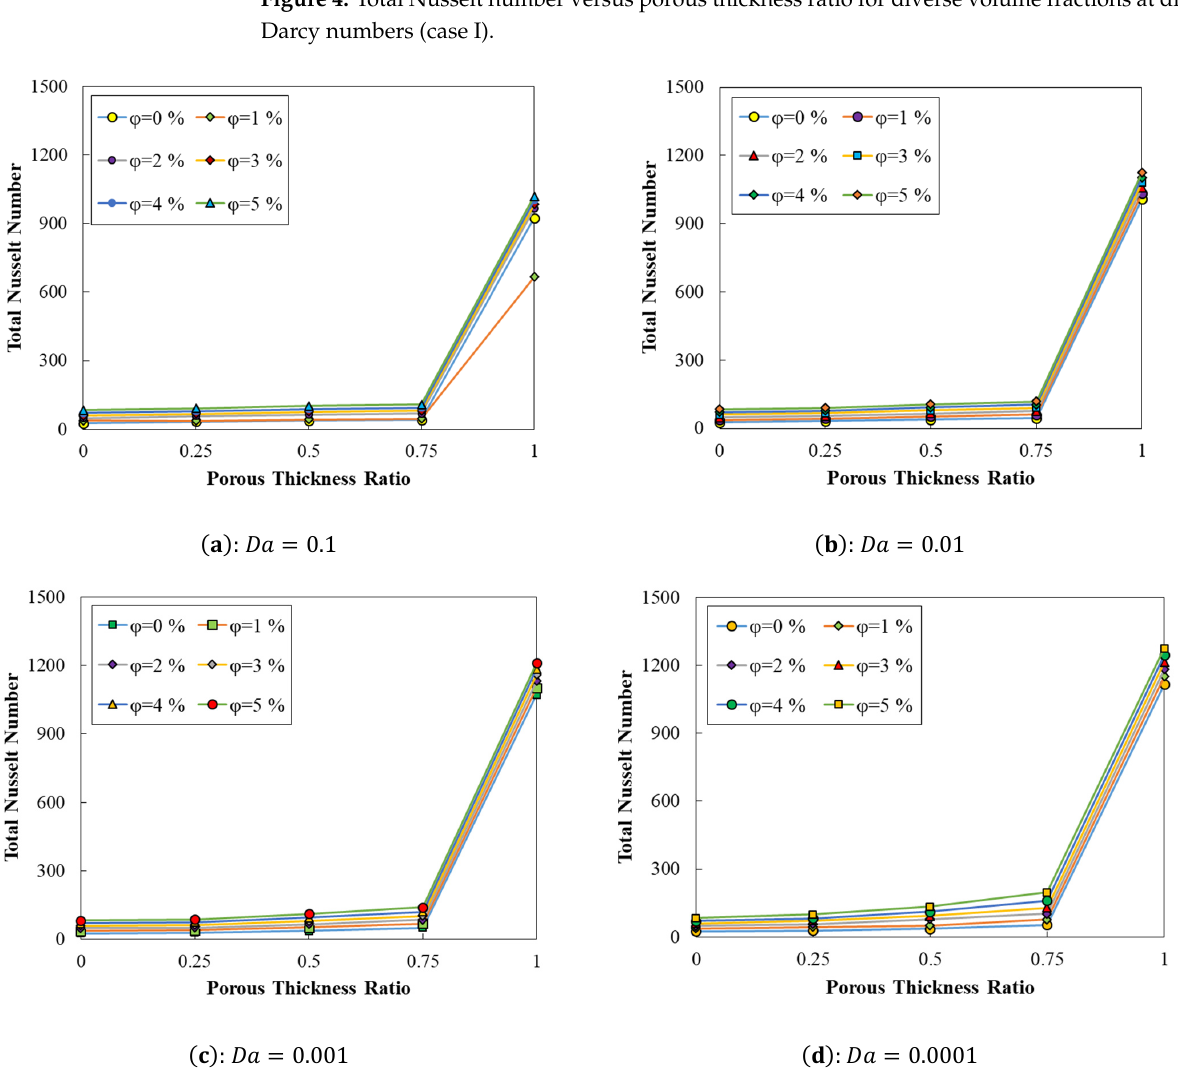
Figure 5. Total Nusselt number versus porous thickness ratio for diverse volume fractions at different Darcy numbers (case